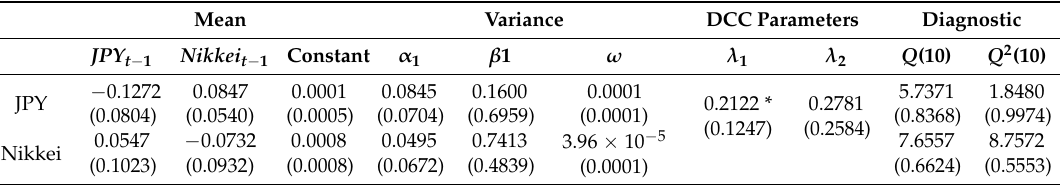
Table 3. Dynamic conditional correlation (DCC) bivariate GARCH model.